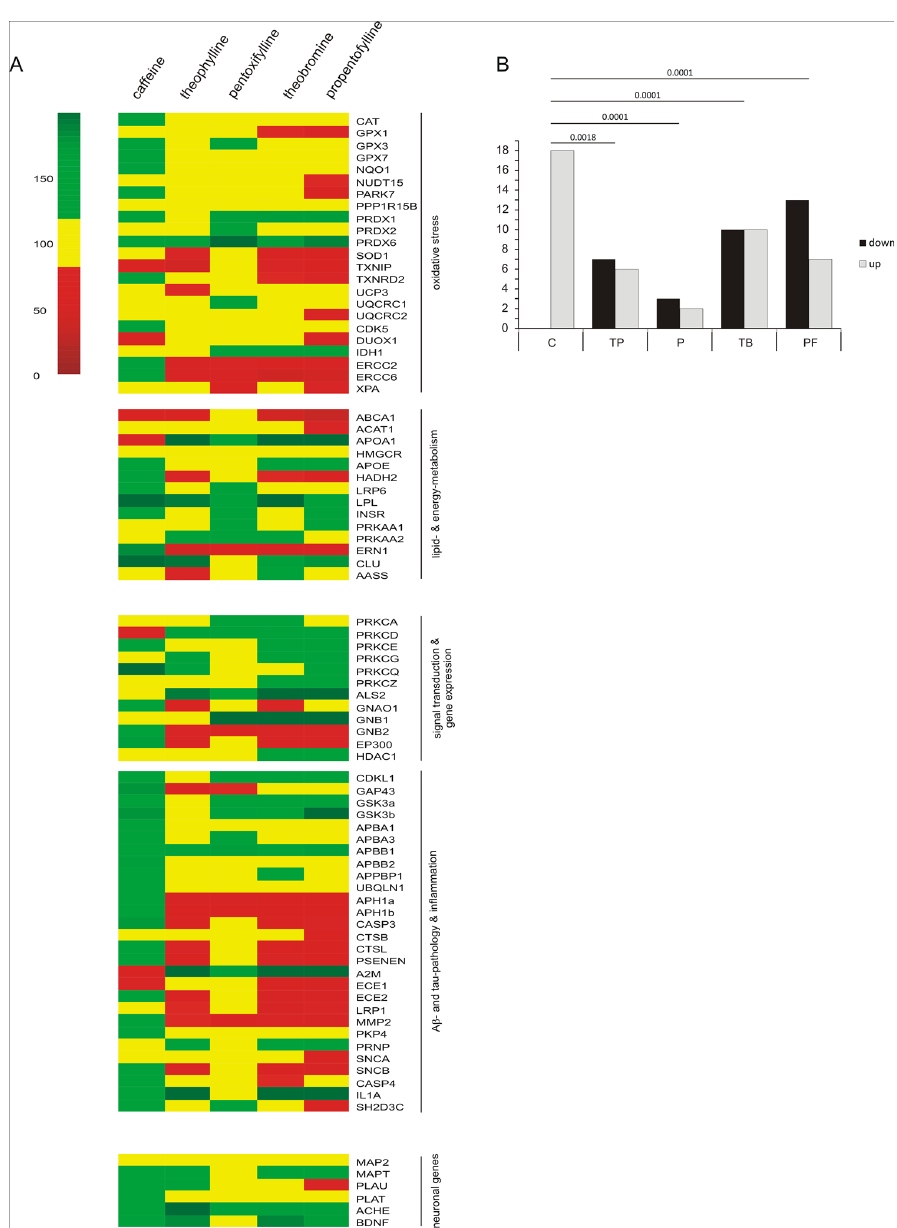
Figure 4. Transcriptional influence of caffeine, theobromine, theophylline, pentoxifylline and propentofylline in SH-SY5Y cells. ( A ) Transcriptional changes of genes related to the different pathways involved in oxidative stress, lipid and energy metabolism, signal transduction and gene expression, and A β - and tau-pathology and inflammation after treatment of human neuroblastoma cells (SH-SY5Y) for 24 h with 100 µ M of the analyzed xanthine derivatives, in comparison to the solvent control, are illustrated in a heatmap. Fold changes greater than the standard deviation (yellow) are highlighted in red when downregulated and in green when upregulated. ( B ) The number of genes which are significantly changed by a single methylxanthine are summarized in a bar